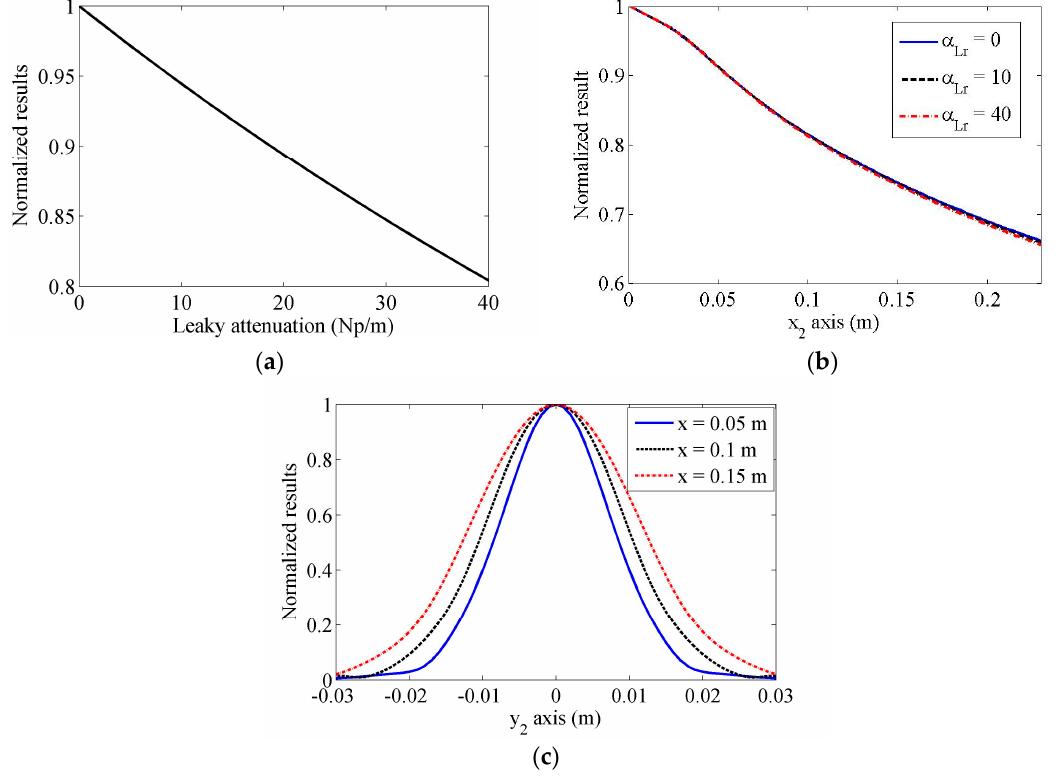
Figure 8. Distributions of normalized magnitudes of received wave results using an angle beam wedge transducer, ( a ) at the distance of x 2 = 0.1 m, ( b ) along x 2 -axis, and ( c ) along y 2 -axis. Different